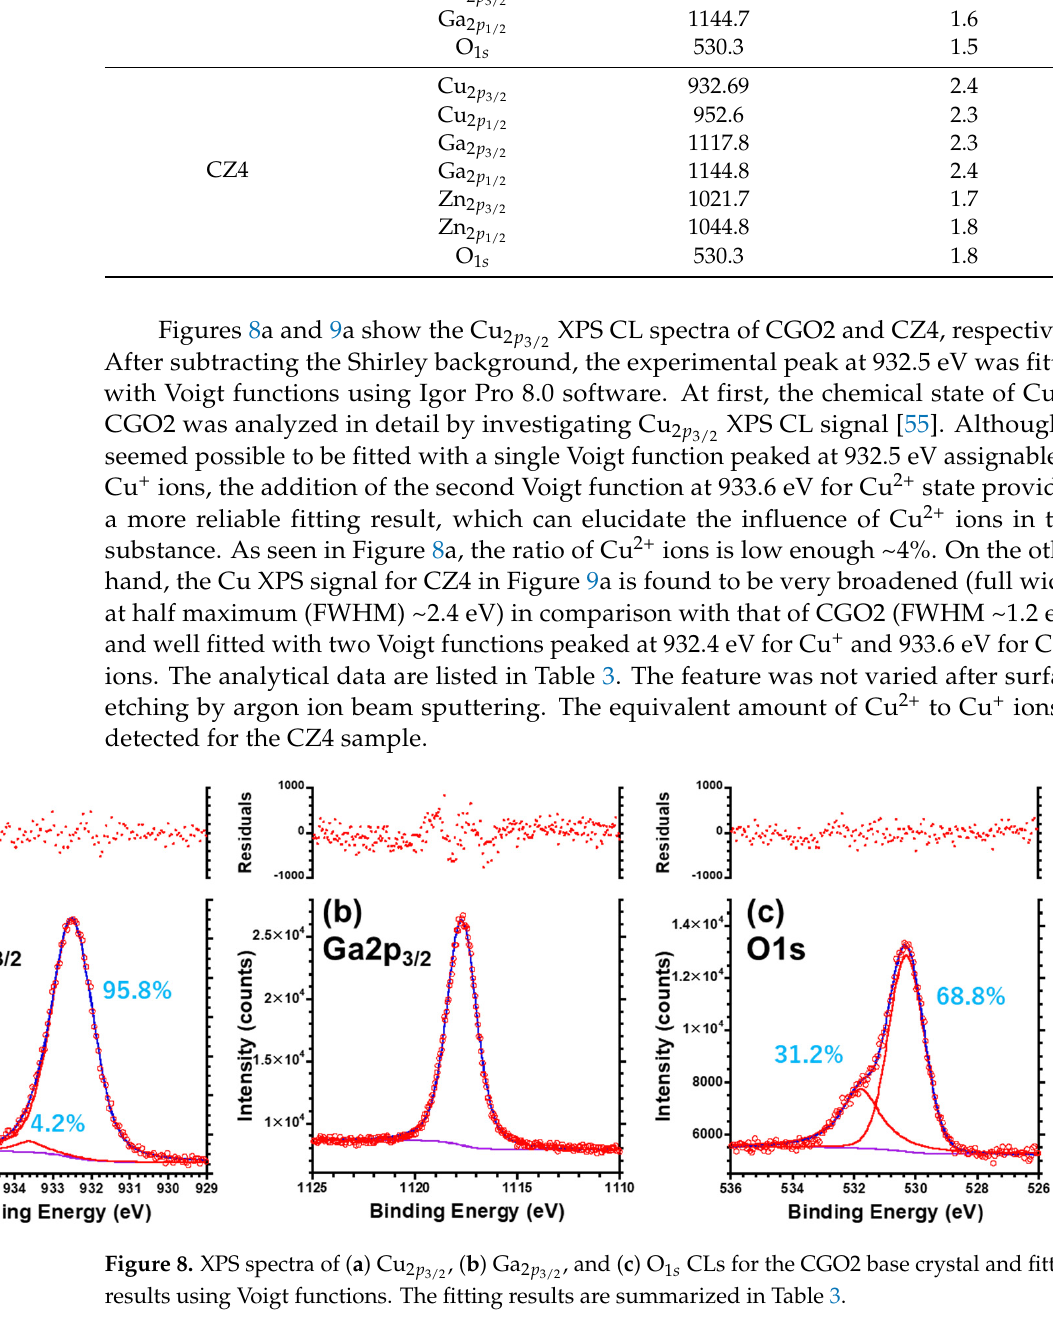
, ( b ) Ga (cid:2870)(cid:3043) , and ( c ) O (cid:2869)(cid:3046) CLs for the CGO2 base crystal and fit ‐ , ( b ) Ga 2 p , and ( c ) O 1 s CLs for the CGO2 base crystal and fitting (cid:3119) / (cid:3118) (cid:3119) / (cid:3118) 3/2 3/2